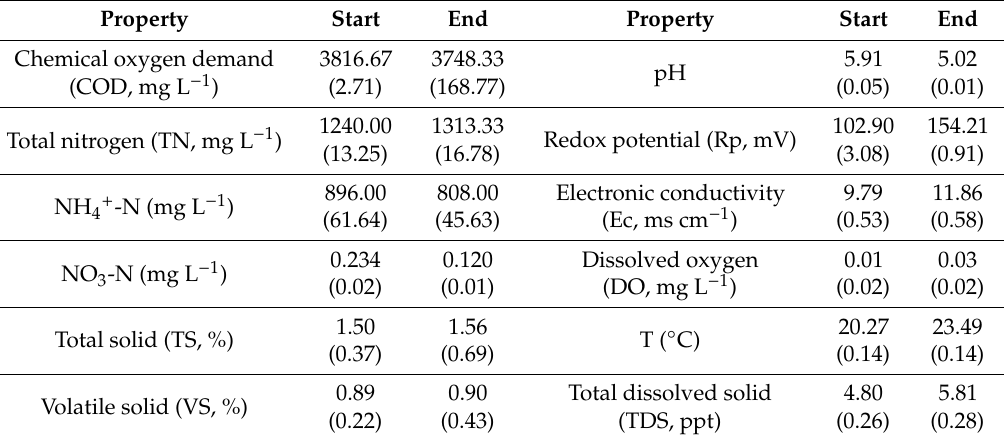
Table 1. Physicochemical properties of biogas digestate (mean (SD)).